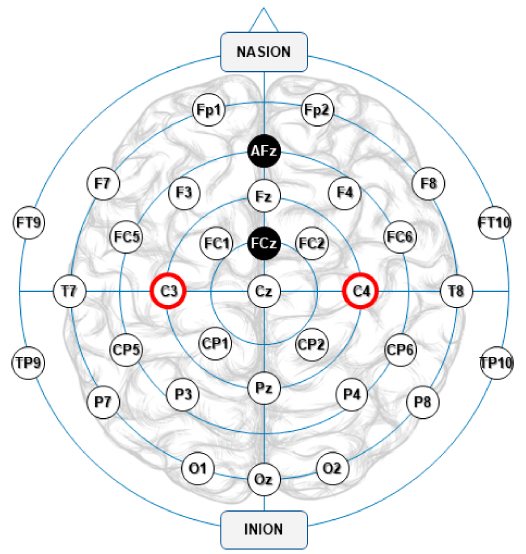
Figure 5. The 10–20 international system of EEG electrode placement.